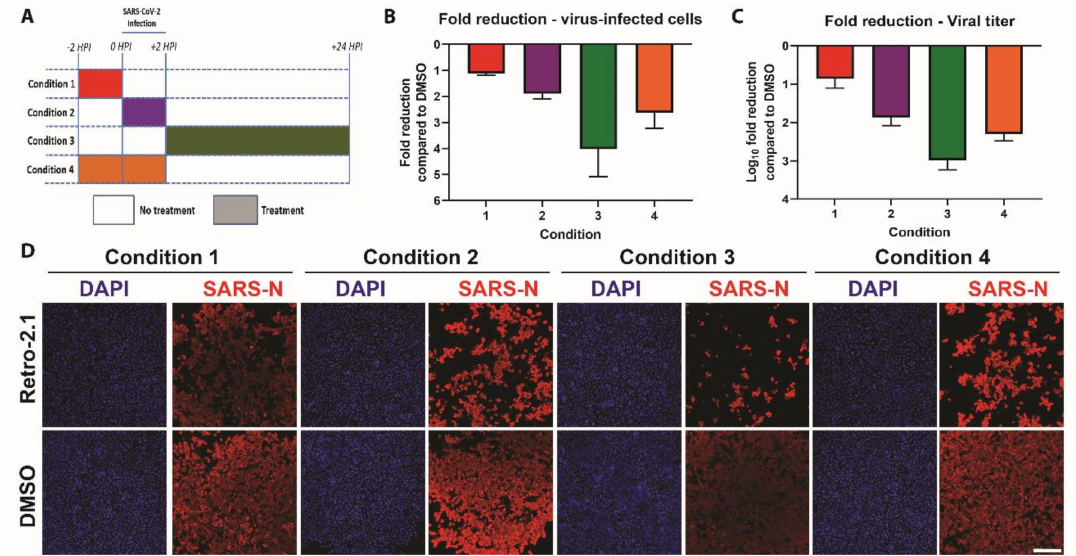
Figure 5. Time-of-addition of Retro-2.1. Time-of-addition was performed by Retro-2.1 treatments pre-, during and / or post-infection ( A ). Confluent Vero E6 cells were fixed 24 h post-infection (hpi) followed by processing for immunostaining with the cross-reactive SARS-CoV nucleoprotein antibody (SARS-N) and DAPI. The percentage of SARS-CoV-2-infected cells ( B ) and viral titers in the supernatant ( C ) were determined at 24 h post-infection. Graphs show means and SD from three individual experiments, performed in two technical replicates. ( D ) Representative images of the indicated conditions. Scale bar: 300 µ